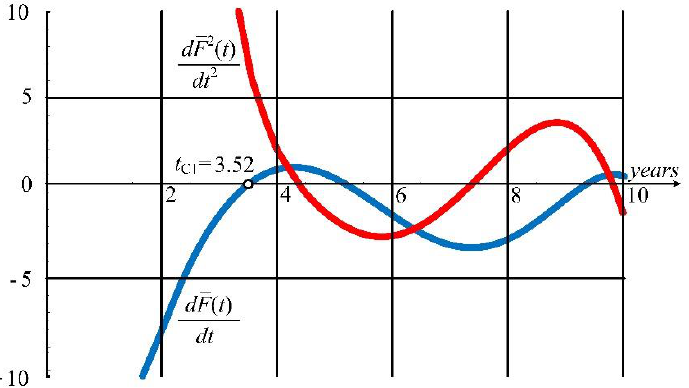
Figure 6. The first and second derivative of a function of average costs for the machine type 1